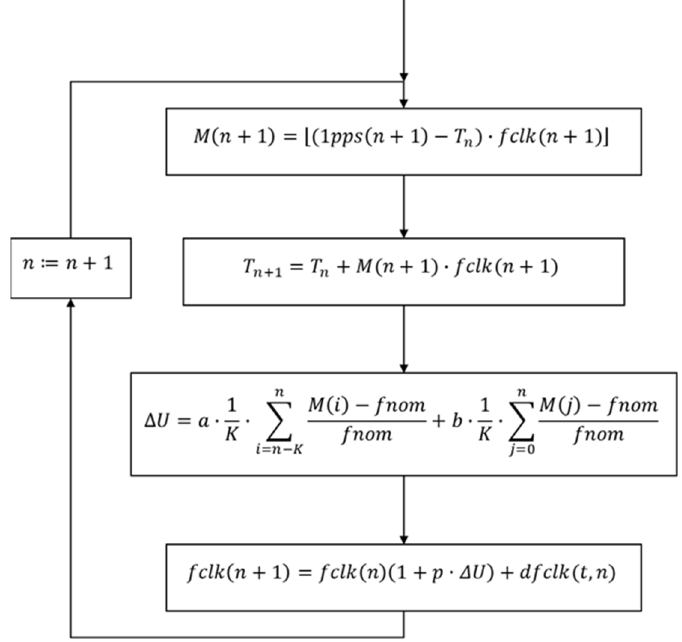
Figure 5. Clock synchronization algorithm.